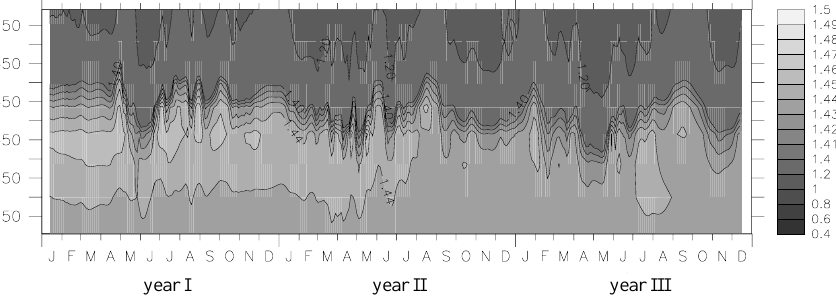
Fig. 13. Temporal evolution of the vertical profile of the salinity anomaly ( 1S = S − 37 . 0, shaded, isohalines inPSU) near the coast of Nice (7.5 ◦ E 43.3 ◦ N–43.5 ◦ N). Isohalines are spaced so as to better show the location of the LIW vein flowing along the coast.